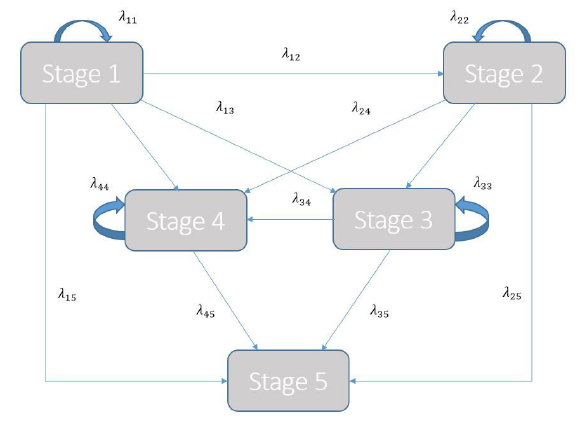
Figure 1 . State transition